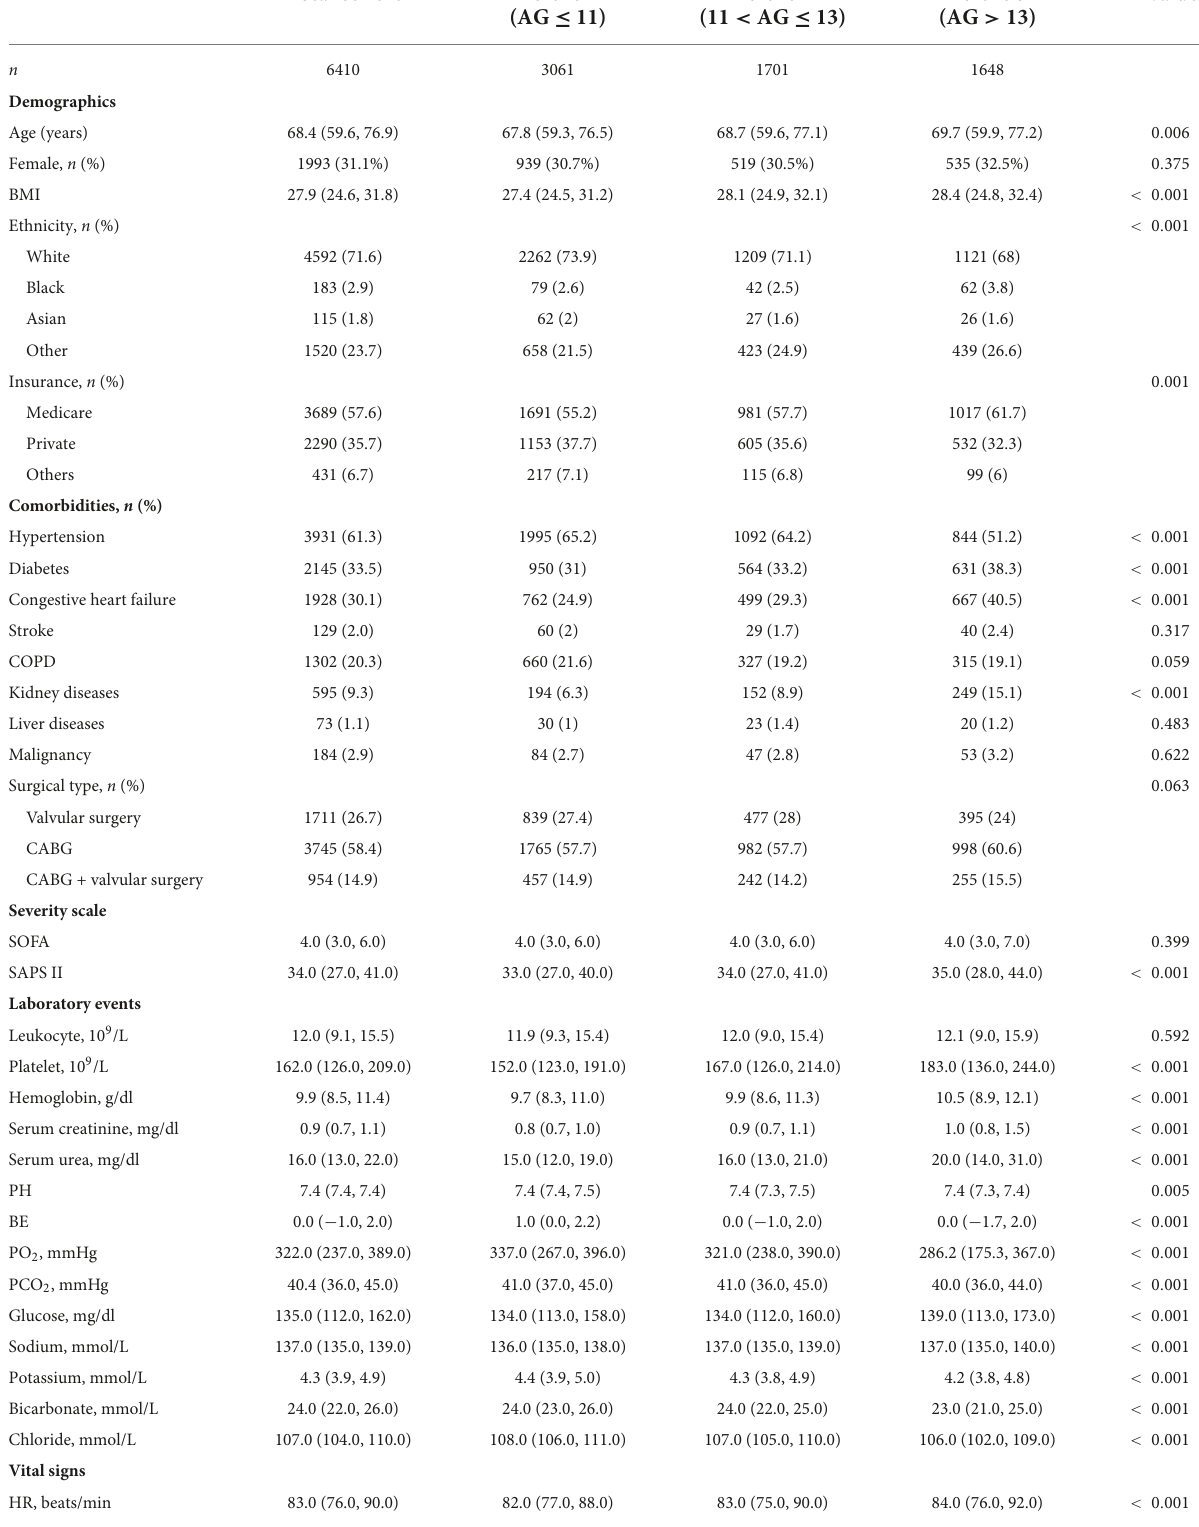
TABLE 1 Baseline characteristics according to the tertile of the initial